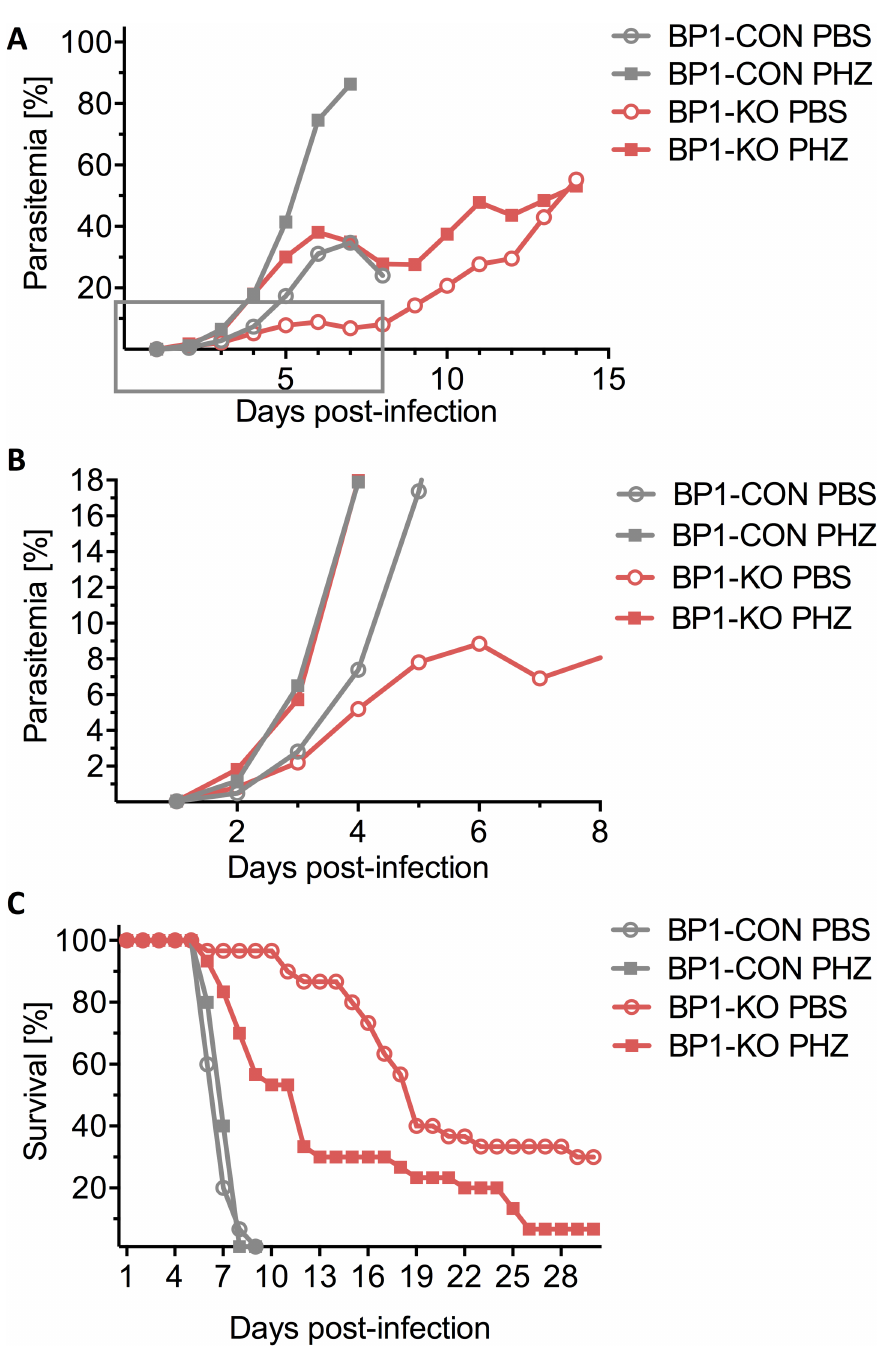
Fig 6. Blood stage growth of berghepain-1 knockout parasitesin phenylhydrazine (PHZ)-treated mice. Swiss Webster mice were pre-treatedwith PHZ (squares) or PBS (circles) with the last dose administered 3 days prior to i.v. injectionof 2x10 6 erythrocytes infected with BP1-CON or BP1-KO parasites. Pooledresults from three biological replicates are shown, two using BP1-KO clone 1 and one using BP1-KO clone 2. A. Parasitemia was monitored daily and the averageparasitemia of all survivingmice is plotted. B. The graph displaysthe data from days 1 through 8 (boxedregionof panel A), to highlightdifferences in parasitemia in the early stage of infection. C. Survival curves of PHZ- and PBS-treated mice after infection with BP1-CON and BP1-KO parasites. Mice were monitored for 30 days and the averagesurvival rate of infected mice is